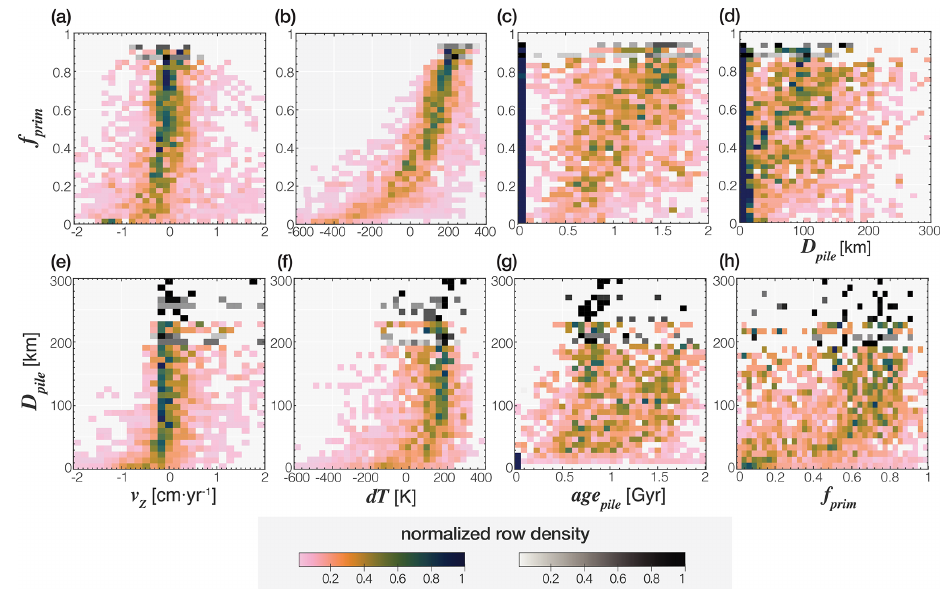
Figure 8. Each panel shows a 2D histogram that relates several selected output quantities of a representative model displaying both pri- mordial blobs and dense piles underneath (regime III.B, model M 300dD , Fig. 2a). For six time steps (4.25–4.5Gyr with steps of 0.05Gyr), selected quantities were calculated for each radial column in the model: pile height D pile , formation age of pile material age pile , mid-mantle primordial-material fraction f prim , mid-mantle radial velocity v z , and mid-mantle temperature anomaly dT . Thermochemical pile thresholds are f bs > 0 . 6 and T pot > 2000K. Mid-mantle is defined as the depth range 1000–2000km. The formation age of pile material is volume- averaged over the full pile thickness and weighted by the basaltic fraction. Each row in the histograms is normalized by the total counts of the row. For rows in greyscale, the number of counts in these rows represents less than 1% of the total